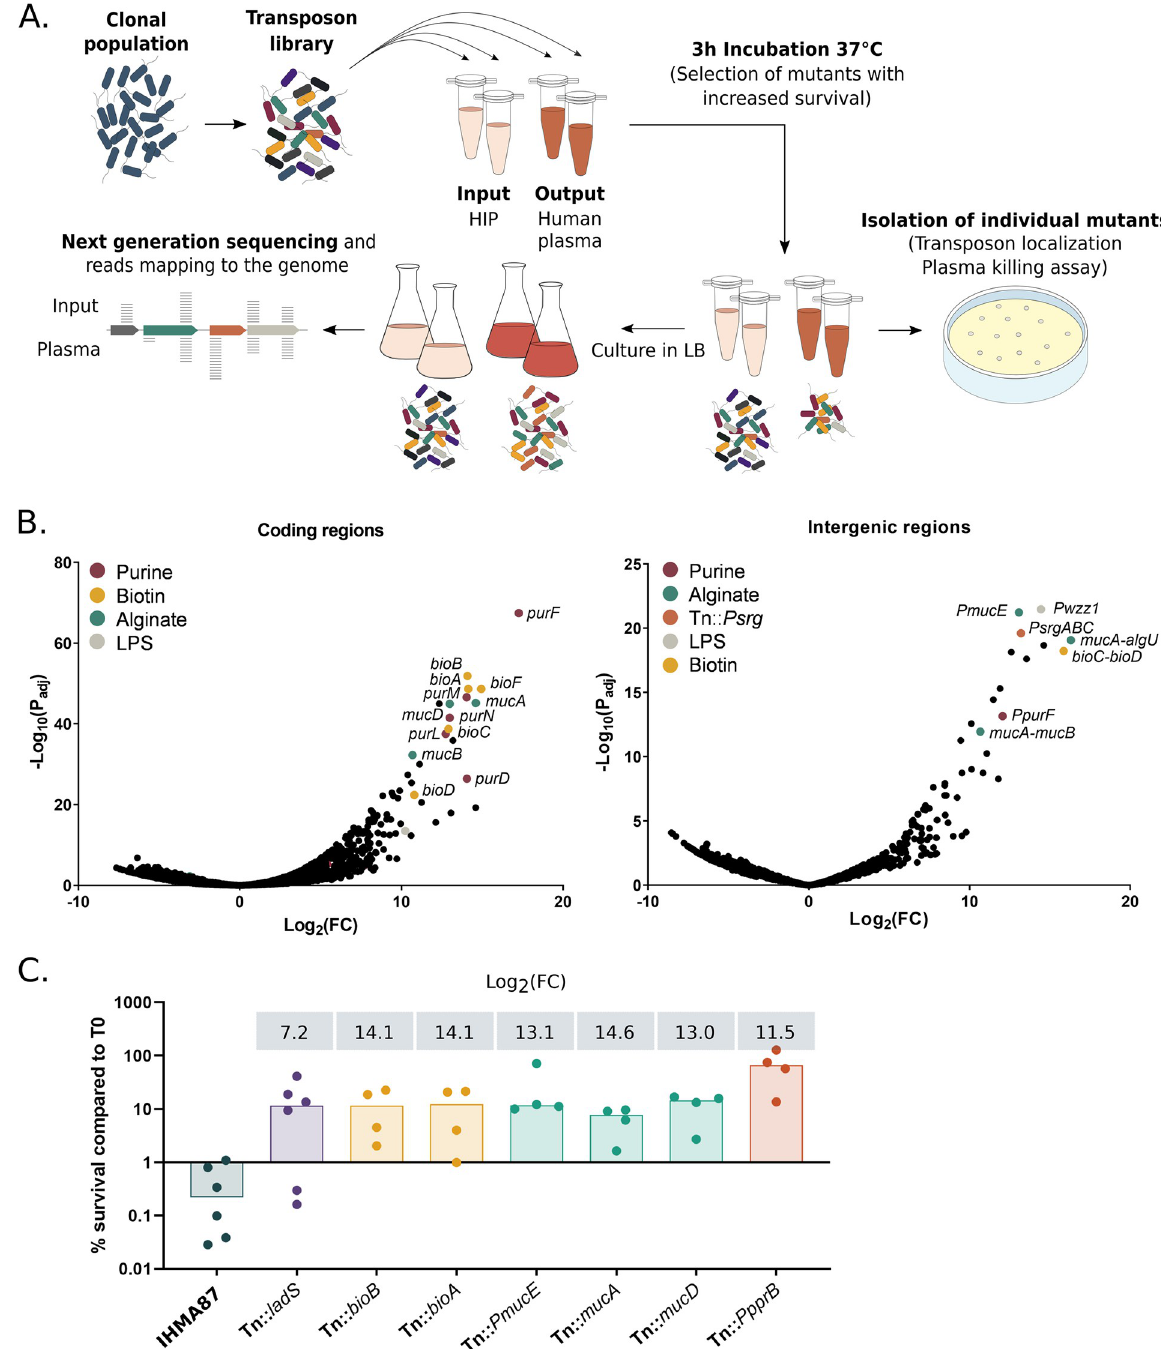
Fig 1. Gain-of-function Tn-seq reveals common and novel pathways contributing to P . aeruginosa survival in plasma. A. Schematic representation of the screening method used for this study. A transposon-insertion mutant library was generated in the plasma-sensitive clinical isolate P . aeruginosa IHMA87 and exposed either to human plasma or to HIP (input) for 3 h. Aliquots were plated on LB and individual transposon mutants were stored for further analysis. B. Bioinformatics analyses presented as Volcano plots. Insertions in coding regions (left) and intergenic regions (right) were analyzed separately. Significant hits in genes involved in the same pathway are shown in the same color. C. Survival of isolated transposon mutants following incubation for 3 h in plasma. Survival rates were calculated based on CFU measurements. The dataset was log-transformed, and rates for all mutants were significantly different from rates for the wild-type strain ( p -value < 0.005). Log 2 (Fold- Change (FC)) obtained from the Tn-seq analysis for each gene or intergenic region is indicated above the histogram.